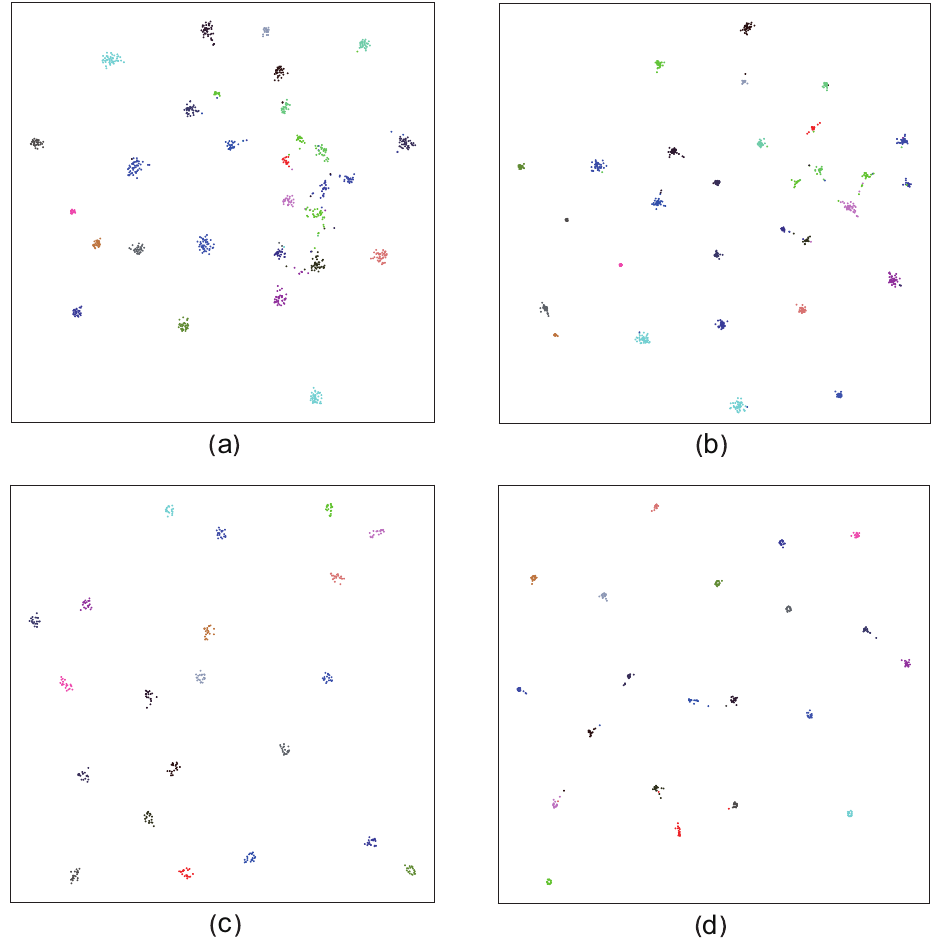
Figure 18. Visualization results of predictions of Cycle MLP and SSKDNet on the AID dataset and the UCM dataset. ( a , b ) represent the T-SNE results on the AID dataset. ( c , d ) represent the T-SNE results on the UCM